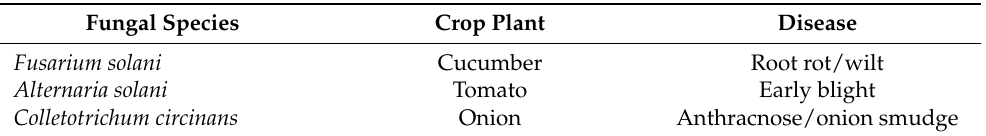
Table 1. List of the three pathogenic fungal species used in this study, the crop plant from which they were isolated, and their disease symptoms. Fungal Species Crop Plant Disease Fusarium solani Cucumber Root rot/wilt Alternaria solani Tomato Early blight Colletotrichum circinans Onion Anthracnose/onion